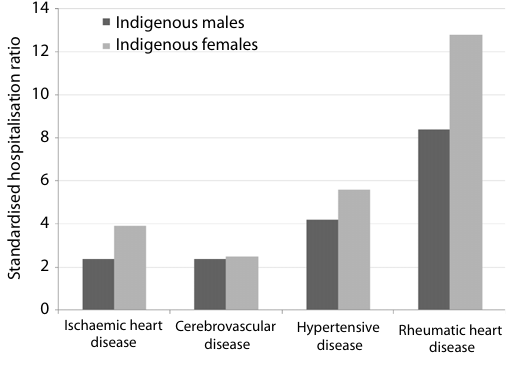
Figure 5. Standardised rates of hospitalisation among indigenous versus non-indigenous Australians 2005– 2006, by specific cardiovascular cause and gender